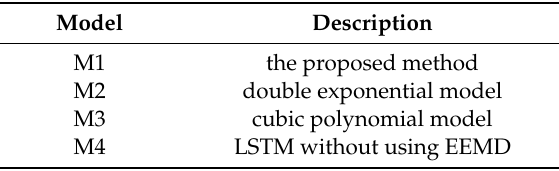
Table 1. The four models of battery RUL prediction